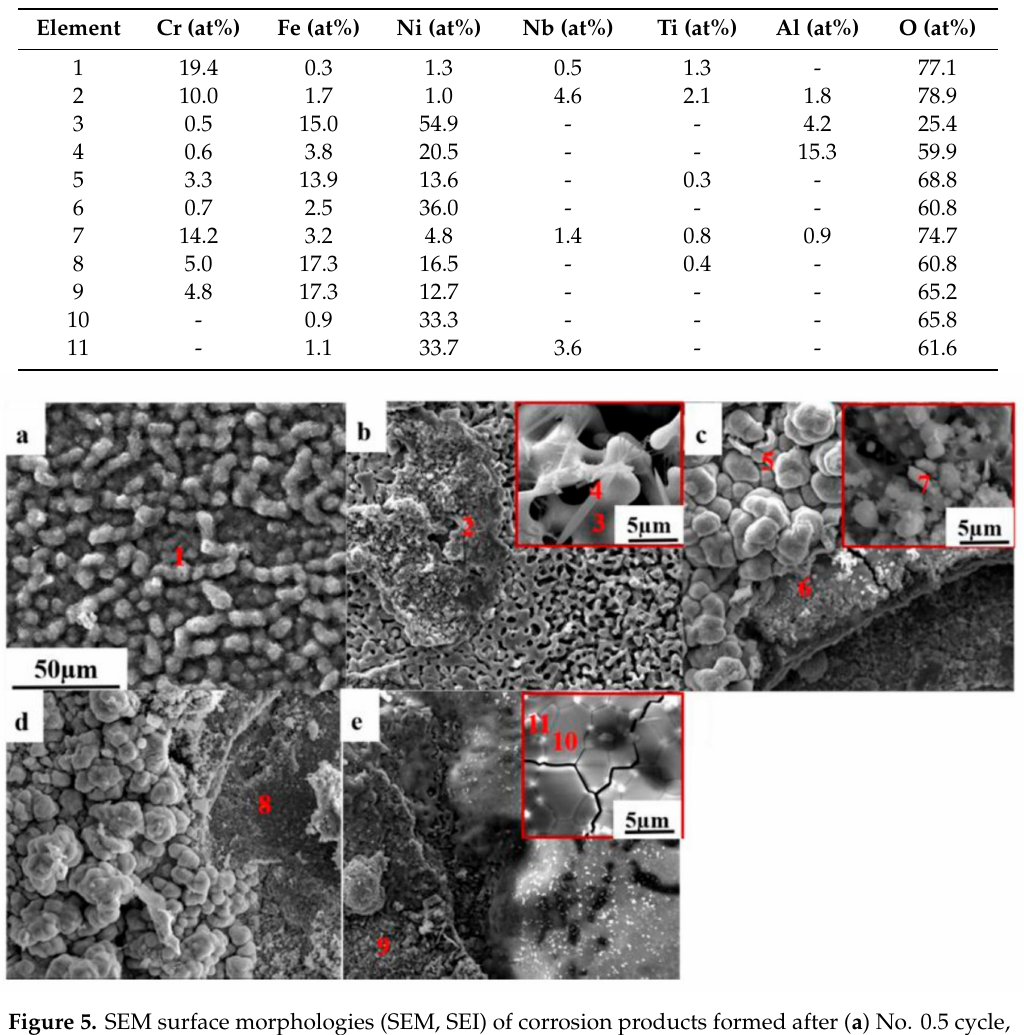
Figure 5. SEM surface morphologies (SEM, SEI) of corrosion products formed after ( a ) No. 0.5 cycle, ( b ) No. 1.5 cycle, ( c ) No. 2.5 cycle, ( d ) No. 3.5 cycle, and ( e ) No. 9.5